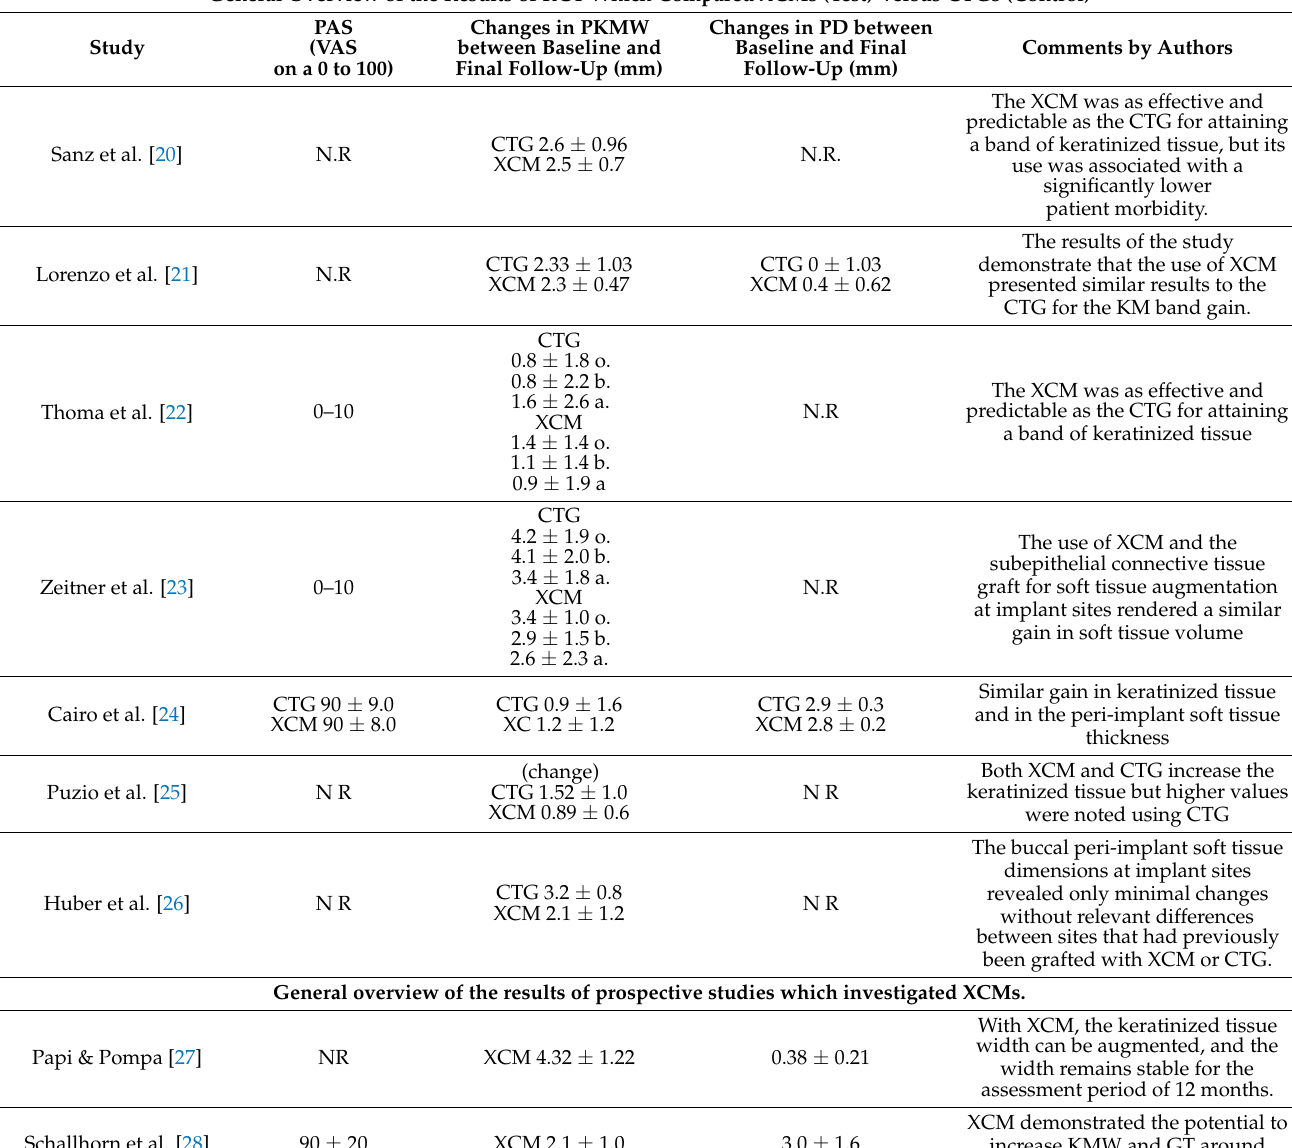
Table 4. General overview of the results reported by selected RCT which compared CTG (control) versus XCM